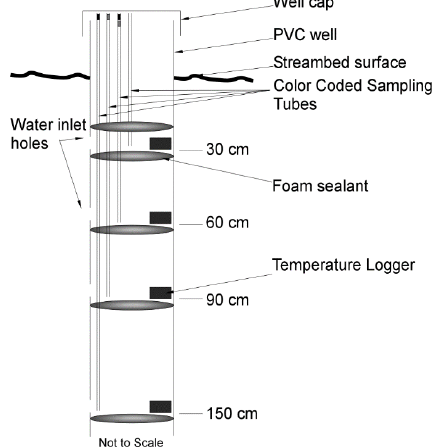
Figure 2. Detailed schematic of the design of the multilevel sampler.